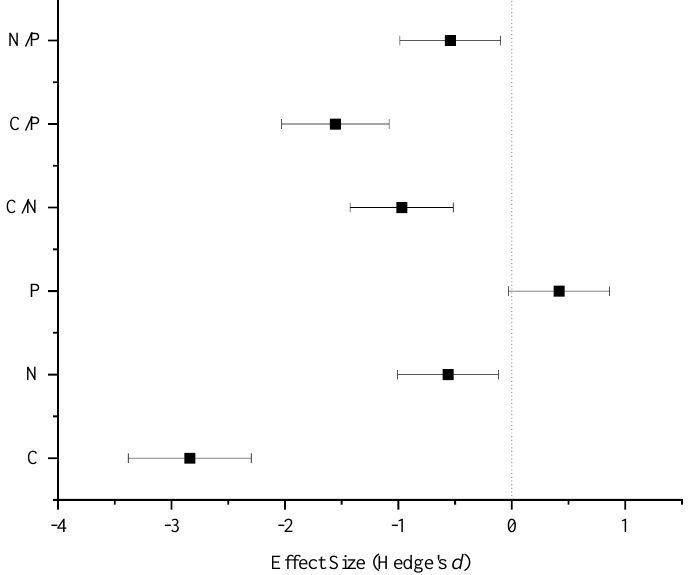
Figure 3. Rock C, N, and P stoichiometry in two rock types. Note: FR: fresh rock. WR: weathered rock. C and P data are reported in this study. N data are sourced from [26]. Error bars indicate SE. Different letters of a and b indicate that values are significantly different at the p = 0.05 level between the two rock types.